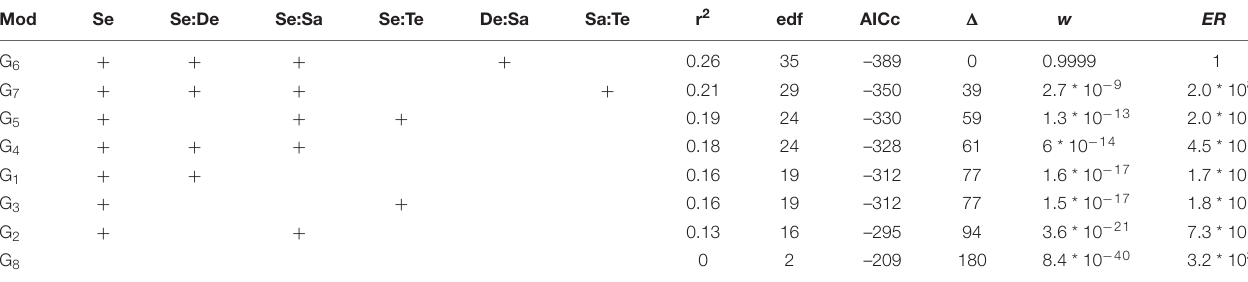
TABLE 4 | Summary of information-criteria-based model selection for the Pielou evenness (J’).